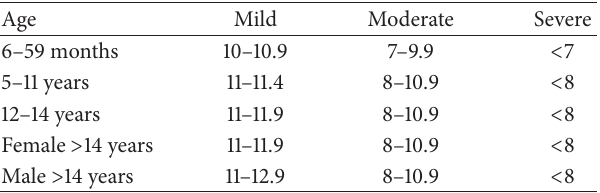
Table 1: Haemoglobin concentrations (g/dL) for the diagnosis of anaemia and assessment of severity according to the World Health Organization.